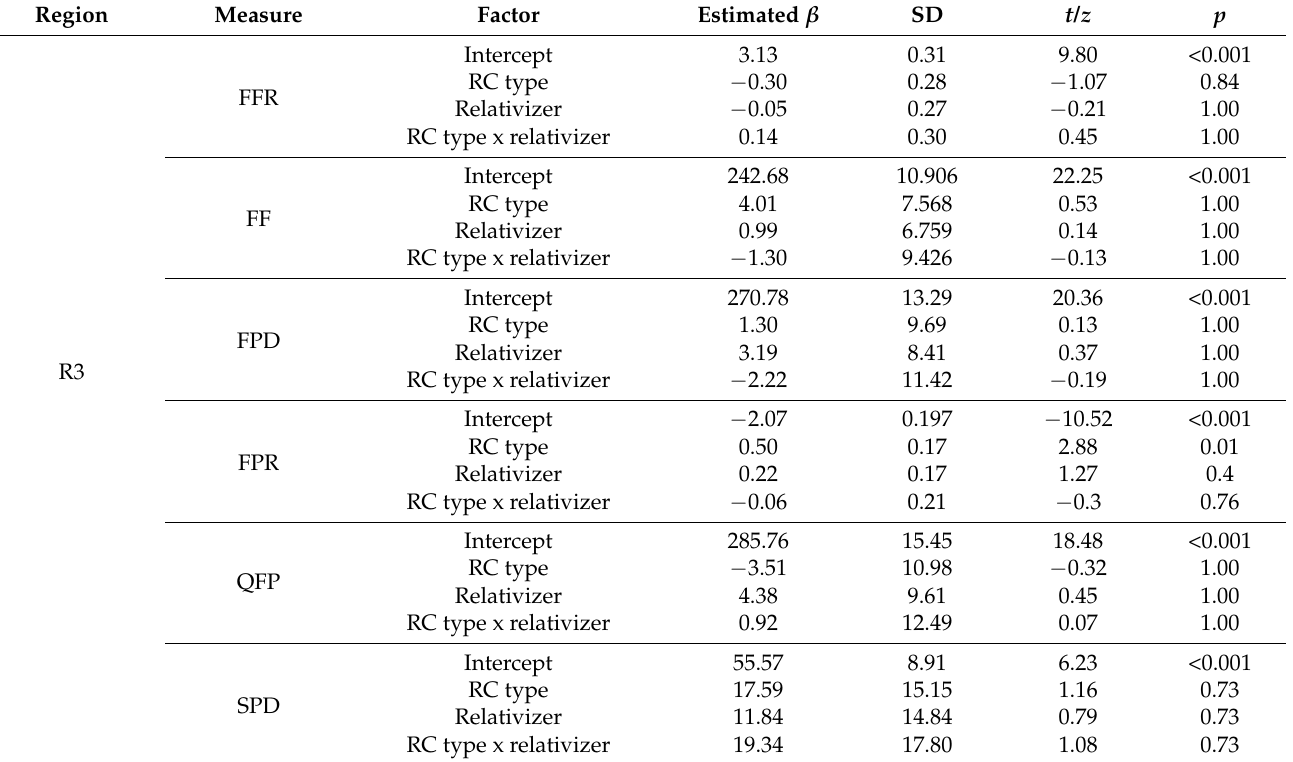
Table 6. Estimated values from the linear mixed-effect models and mixed-effect logistic regression for the contrast que versus el cual at R3, R4, and R5. Eye movement measures are first-fixation rate (FFR), first fixation (FF), first-pass duration (FPD), first-pass regression (FPR), quasi-first-pass reading time (QFP), and second-pass duration (SPD). t -values refer to reading time measures, and z -values refer to probability